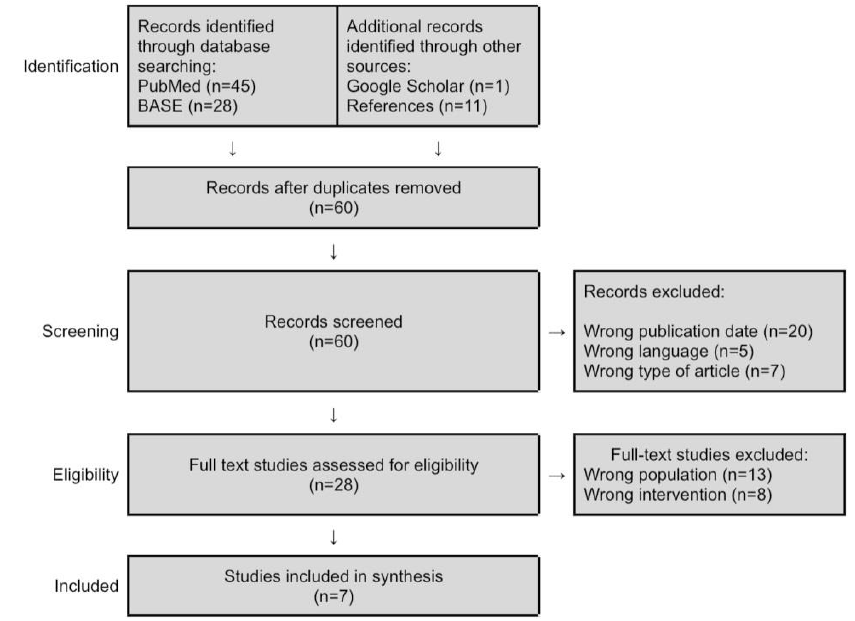
Figure 1. PRISMA flowchart [19]. Description in the text.